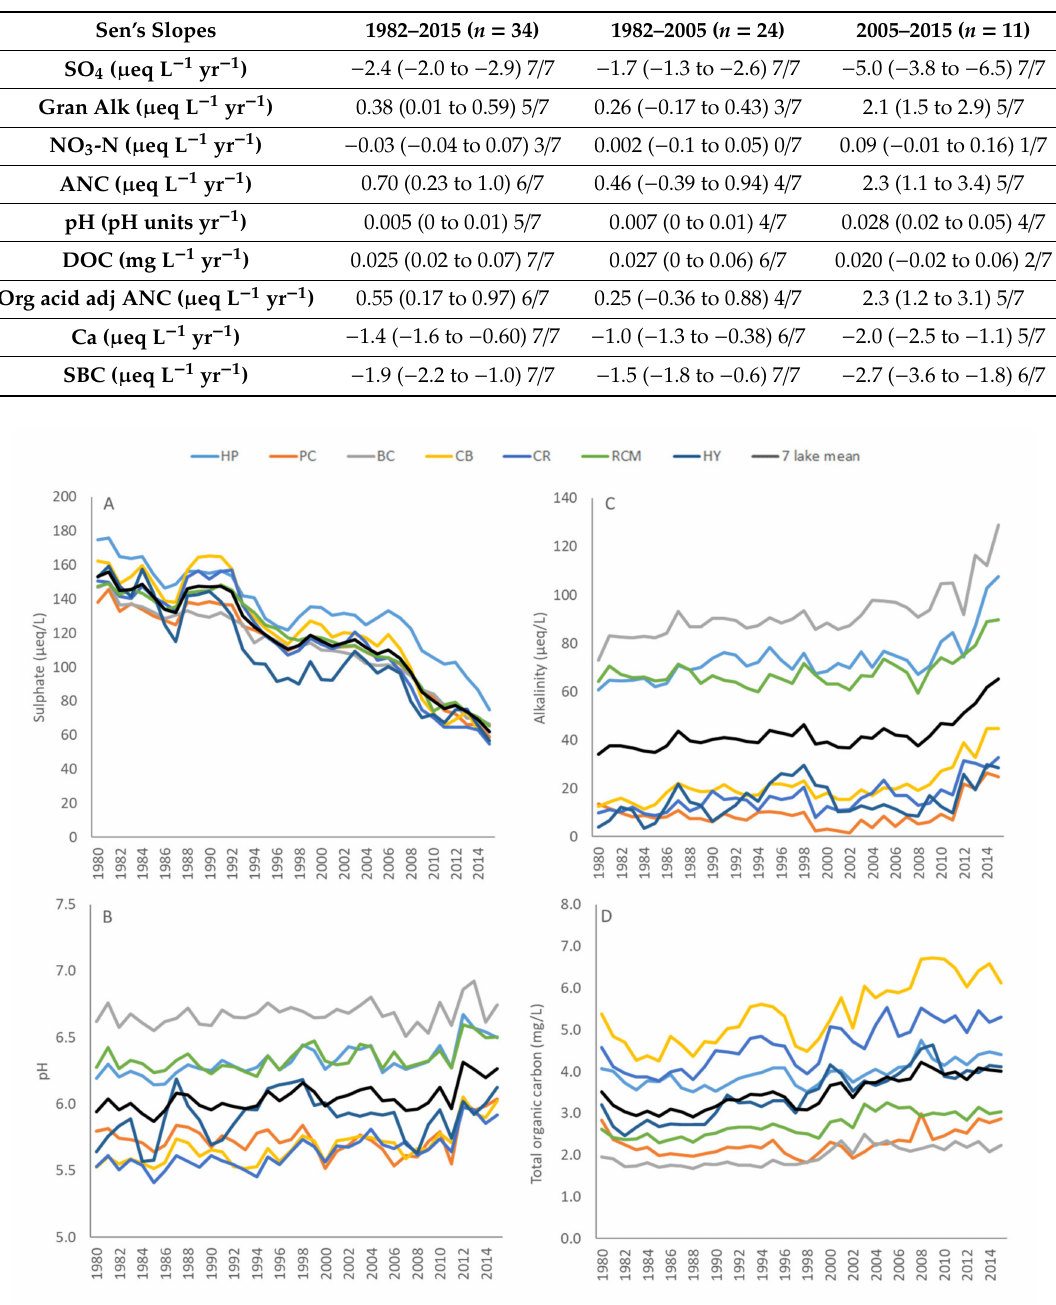
Table 2. Sen’s slopes—medians of the seven lakes, ranges of slopes (in parentheses) and number of lakes with significant trends at p < 0.05.